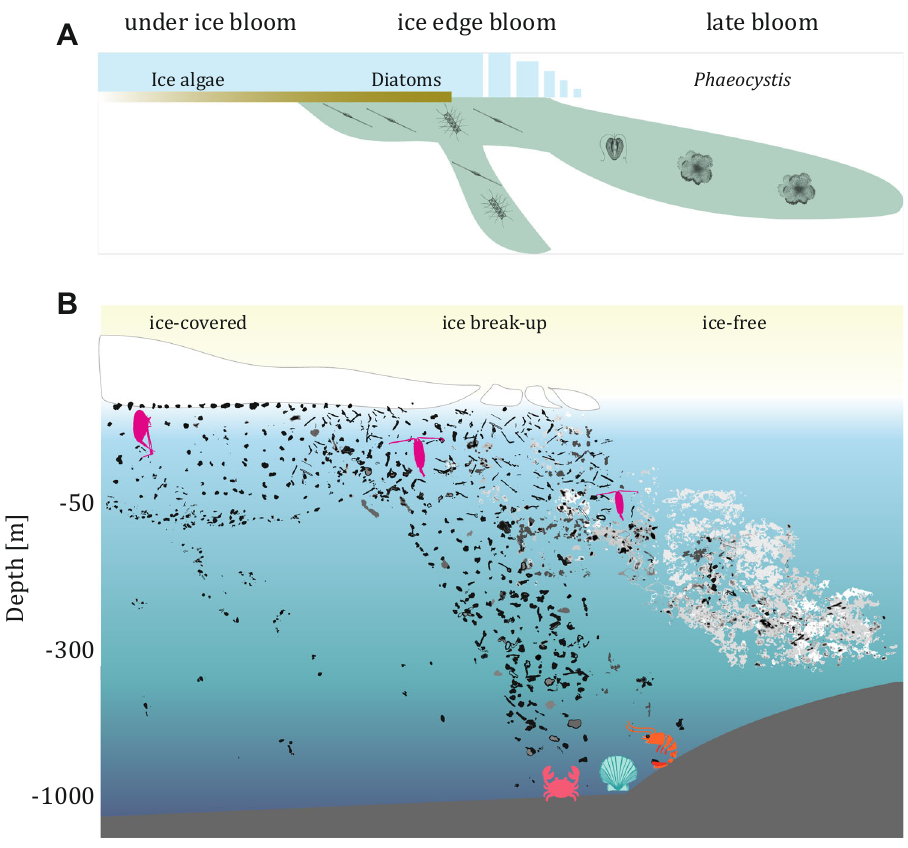
Fig. 6 Conceptual schemes of the phases of the Arctic ice-associated phytoplankton bloom dynamics extended by the corresponding morphological changes of marine snow. The exemplary marine snow images assessed by the UVP (Underwater Vision Pro fi ler) are presented over various phases of the Arctic phytoplankton bloom. A Conceptual scheme of the stages of the Arctic phytoplankton bloom. B Conceptual scheme of the corresponding modi fi cation in marine snow